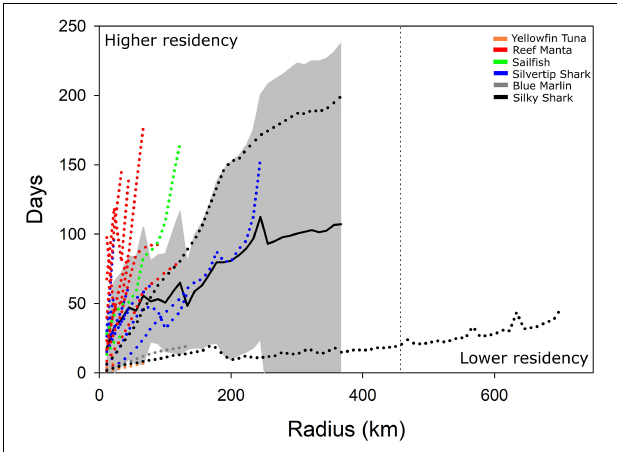
FIGURE 3 | Spatial and temporal changes in residence time (time spent in circles with various radii) of satellite-tagged animals in the BIOT MPA. Overall mean residence time (black line, ± SD shaded area) is shown as is residence time for all individual animals (dotted colored lines). Approximate radius of BIOT MPA is ∼ 450 km (dashed vertical